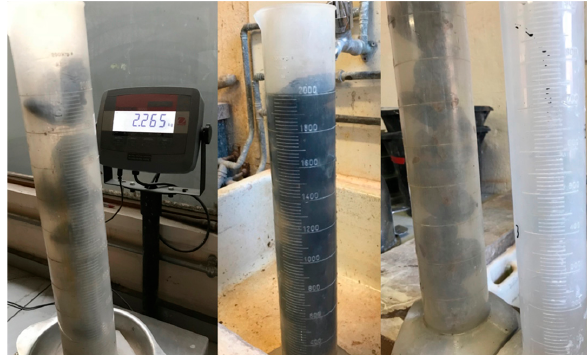
Figure 24. Measurement of displaced water in ballast column. Table 6. Physical properties of ballast tested in